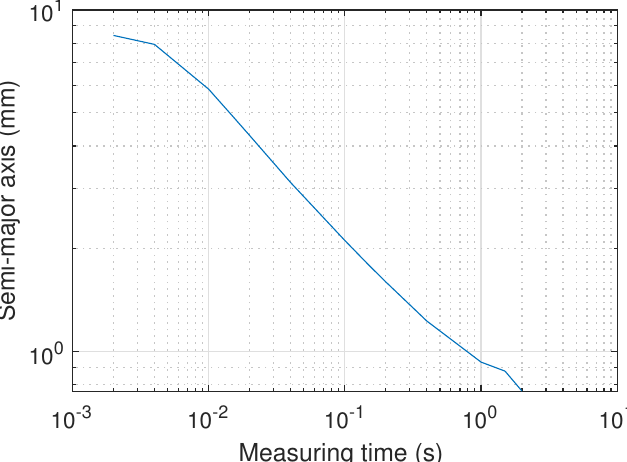
Figure 12. Mean value of the semi-major axis of the error ellipsoid projected on the plane of movement as a function of measurement time.